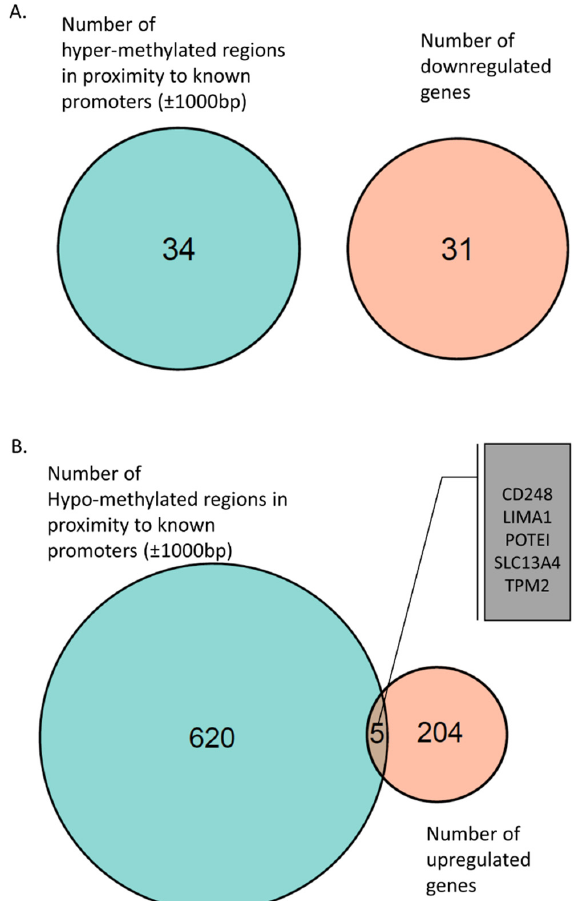
Figure 2. ( A ) Venn diagram of hyper-methylated regions near promoters (±1000 bp) and downregulated genes associated with these promoter regions. ( B ) Venn diagram of hypo-methylated regions near promoters ( ± 1000 bp) and upregulated genes associated with these promoter regions. Five genes were found to be hypo-methylated and upregulated: CD248, LIMA1, POTEI, SLC13A4, and TPM2. Next, we identified 625 hypo-methylated regions in proximity to known gene pro- moters (±1000 bp) (Supplementary Materials, Table S4). Hypo-methylated promoter re-